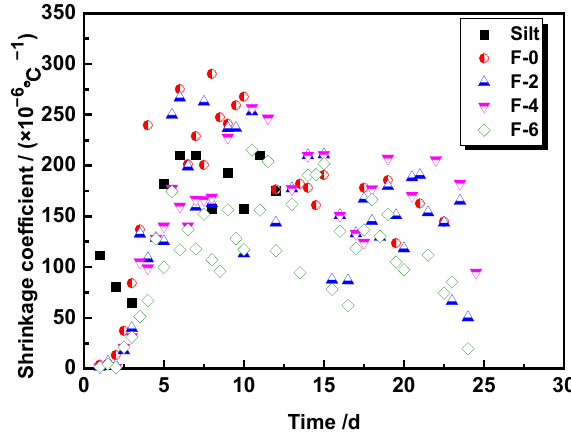
Figure 8. Variation of shrinkage coefficient with time.